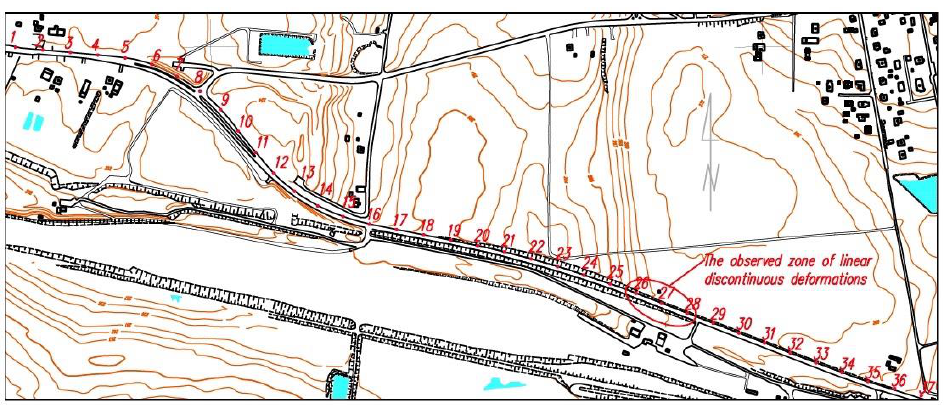
Figure 10. The longitudinal evenness graph of the tested road section obtained with a laser profilo- graph.